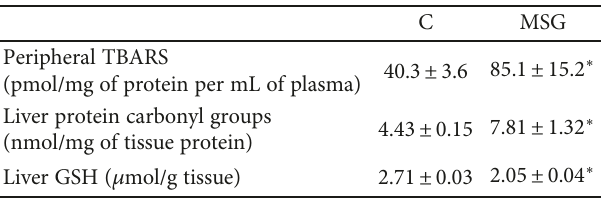
Table 3: Peripheral and liver ( n = 12 and 6 specimens per group, resp.) oxidative stress markers in control (C) and MSG